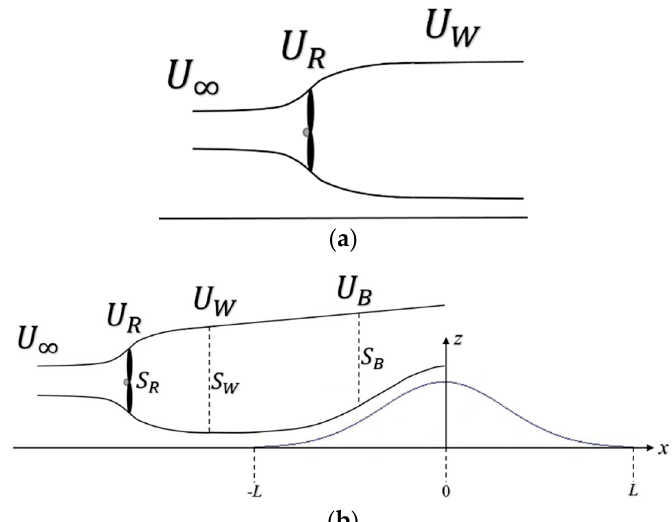
Figure 1. ( a ) Wind turbine wake over a flat terrain; ( b ) the combined effect of the turbine and hill on the wake.